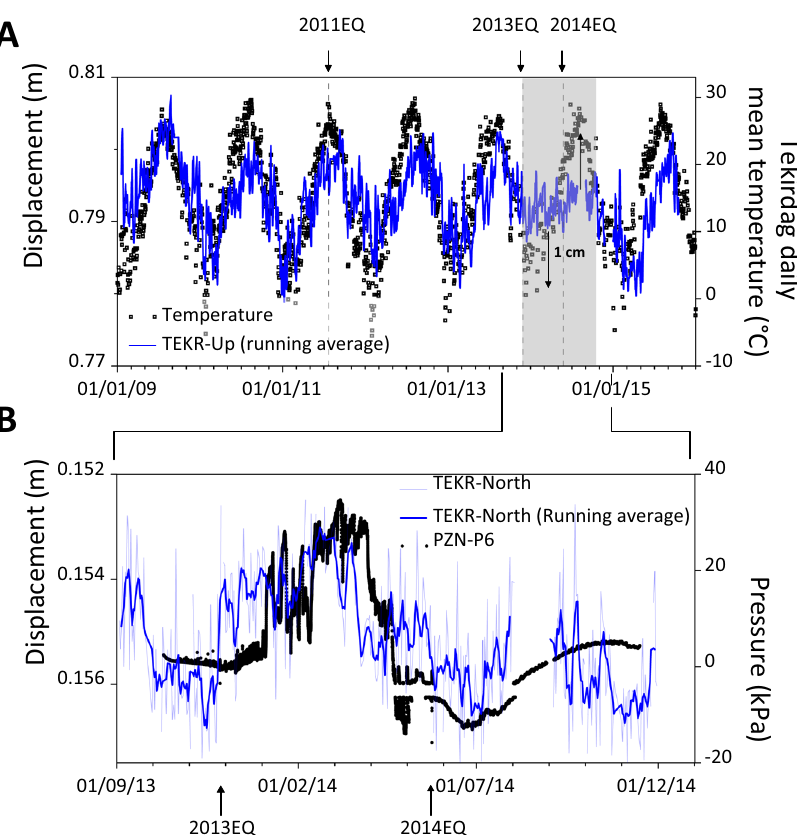
Fig. 4 Pore-pressure versus geodetic data. A Vertical displacement from TEKR geodetic station (non-corrected for seasonal fl uctuations — blue line) compared to Tekirdag daily mean temperatures (black squares) suggesting a seasonal ground surface displacement except for a 10-month period that begins in November 2013 (gray area). B Pore pressure measured at 7.08 mbsf during a 13-month period at PZN station (PZN-P6) synchronize after the 2013EQ with the TEKR GPS northern displacement (TEKR-North) corrected for seasonal fl